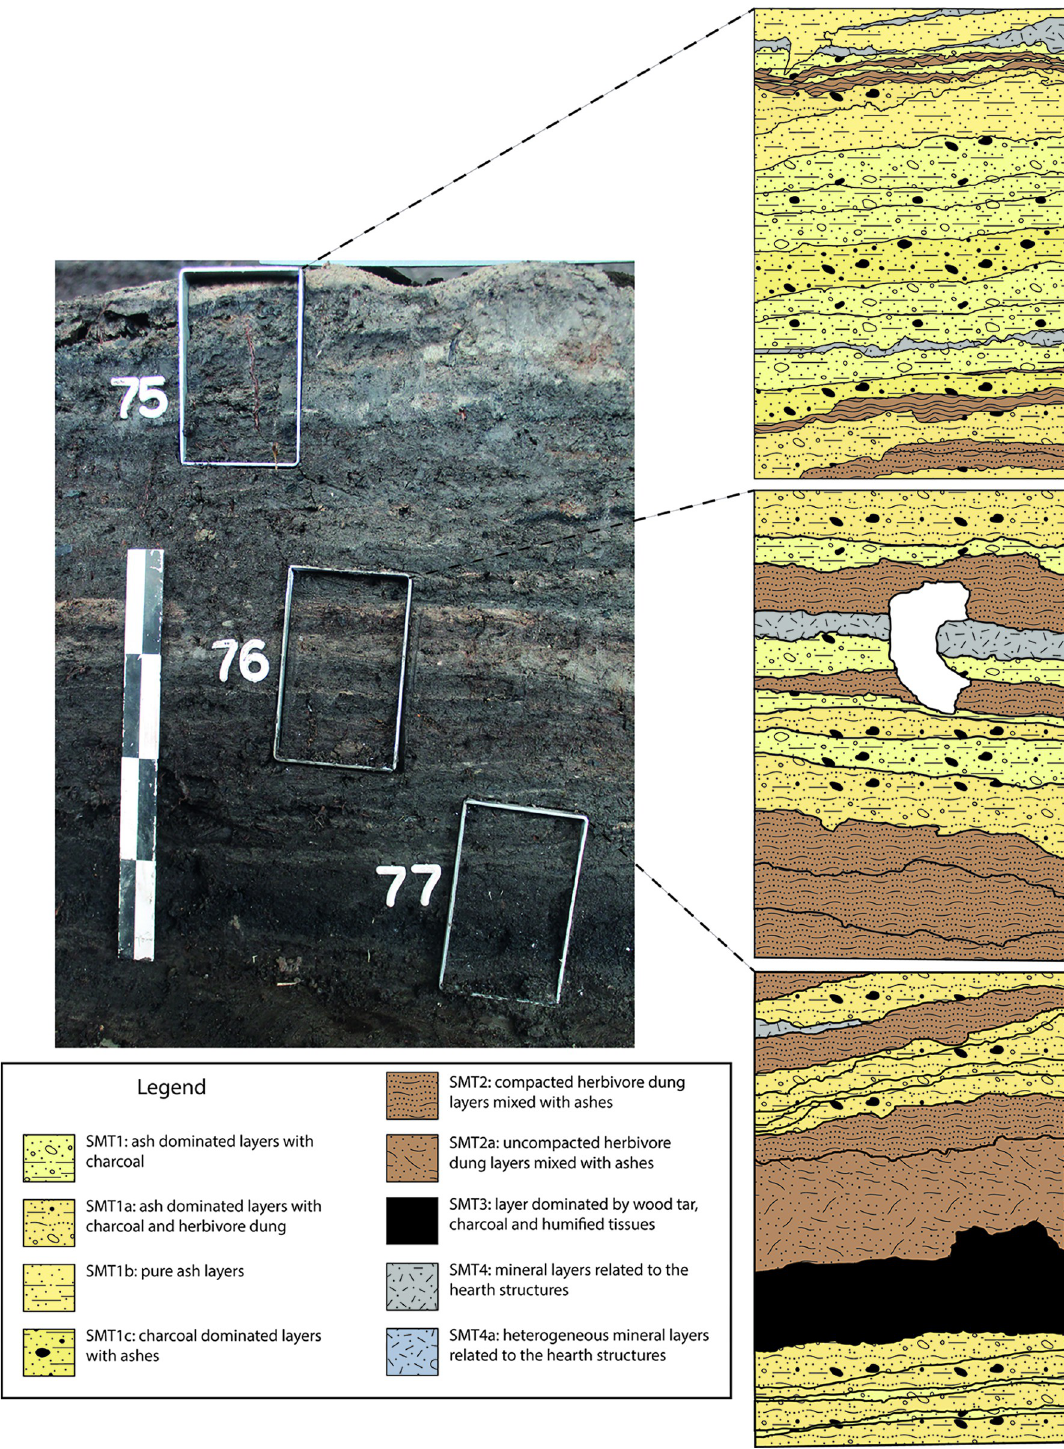
Fig 11. Sampling location of OPP 75–77 and interpretation of the vertical accretion of structure F. Left: detail of Fig 5A, showing the position of samples OPP 75, OPP 76, and OPP 77. Right: interpretation of the thin sections, with a SMT assigned to each sub-unit.